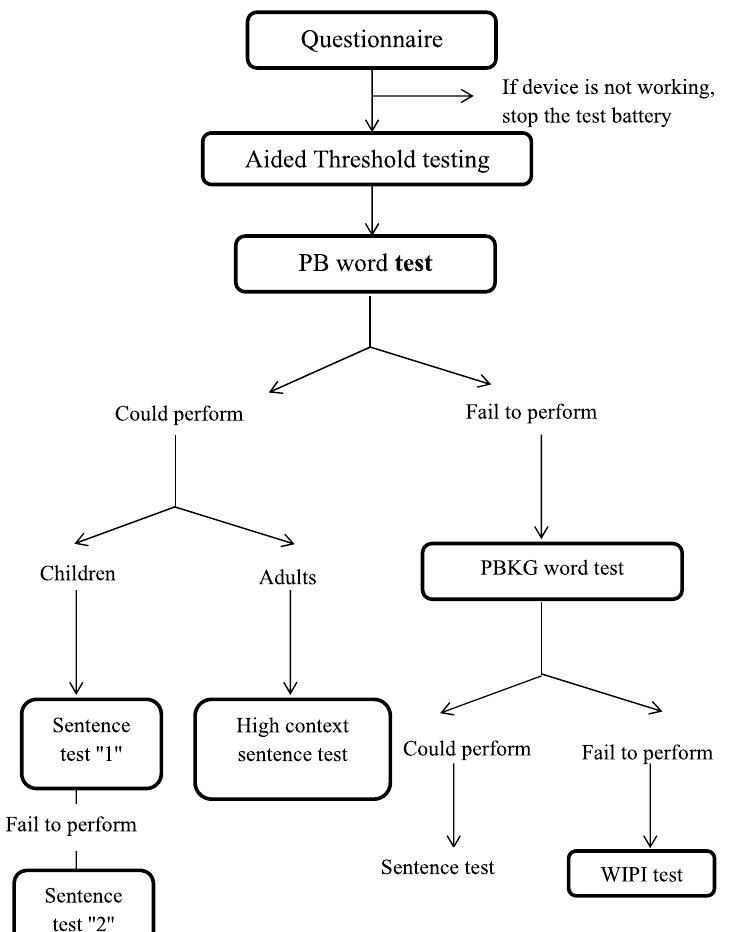
Fig. 1 Test battery flow chart in the study group. Speech perception tests were done with and without VC. Sentence tests were done in quiet and